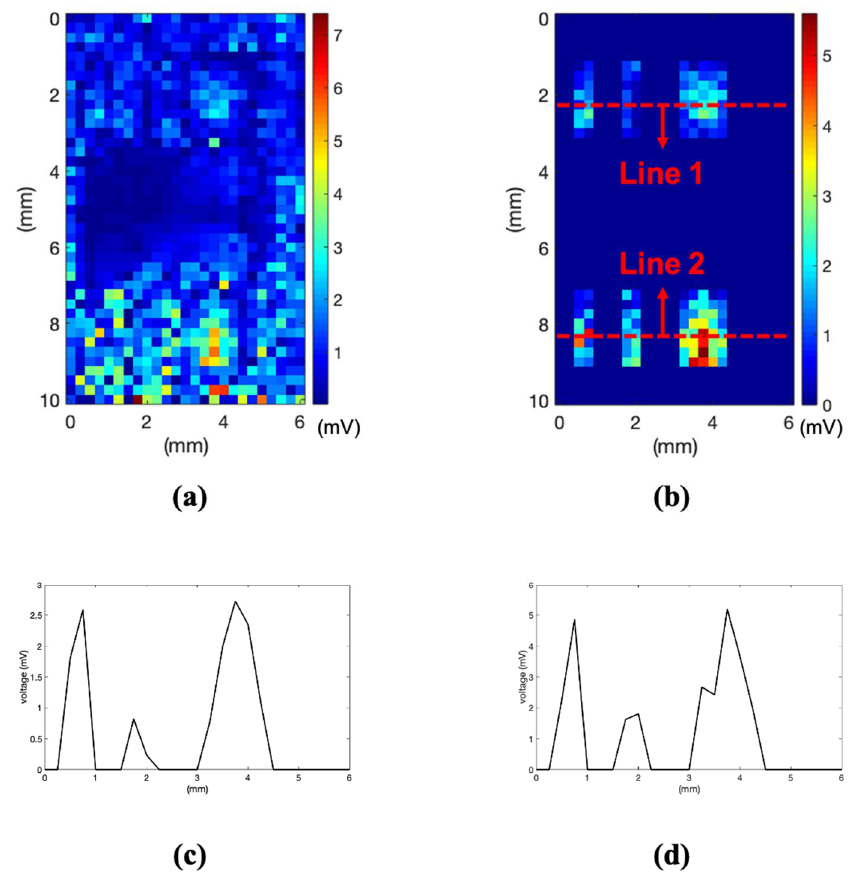
Figure 7. ( a ) C-mode image, ( b ) image reconstructed with only values of soldering part, ( c ) received voltage value along line 1, and ( d ) received voltage value along line 2.